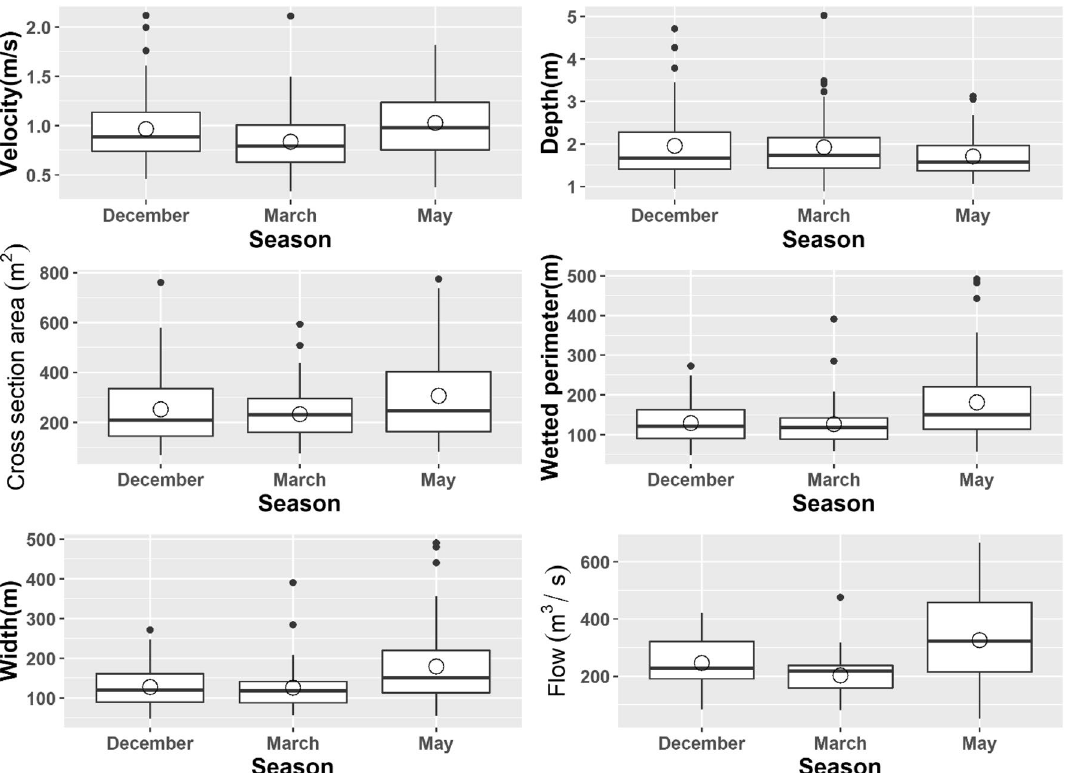
Figure 2. Ganges River dolphins ecological attributes across the dry water season (Dec-early dry, Mar- middle dry and May-late dry; Dry season = December–May; Transition season for both dry and wet respectively = November, June; Wet = July–October) show that individuals are often found in specific hydro- physical habitats, suggesting strong habitat selection. The line’s median value divides the box and means value represented by a hollow circle.